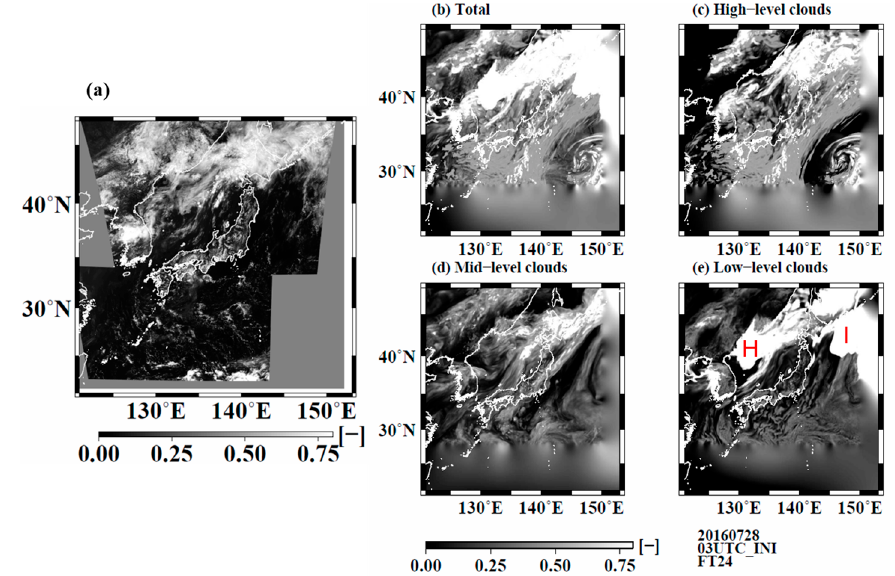
Figure 15. Same as Figure 14, but for on 10 October 2015.